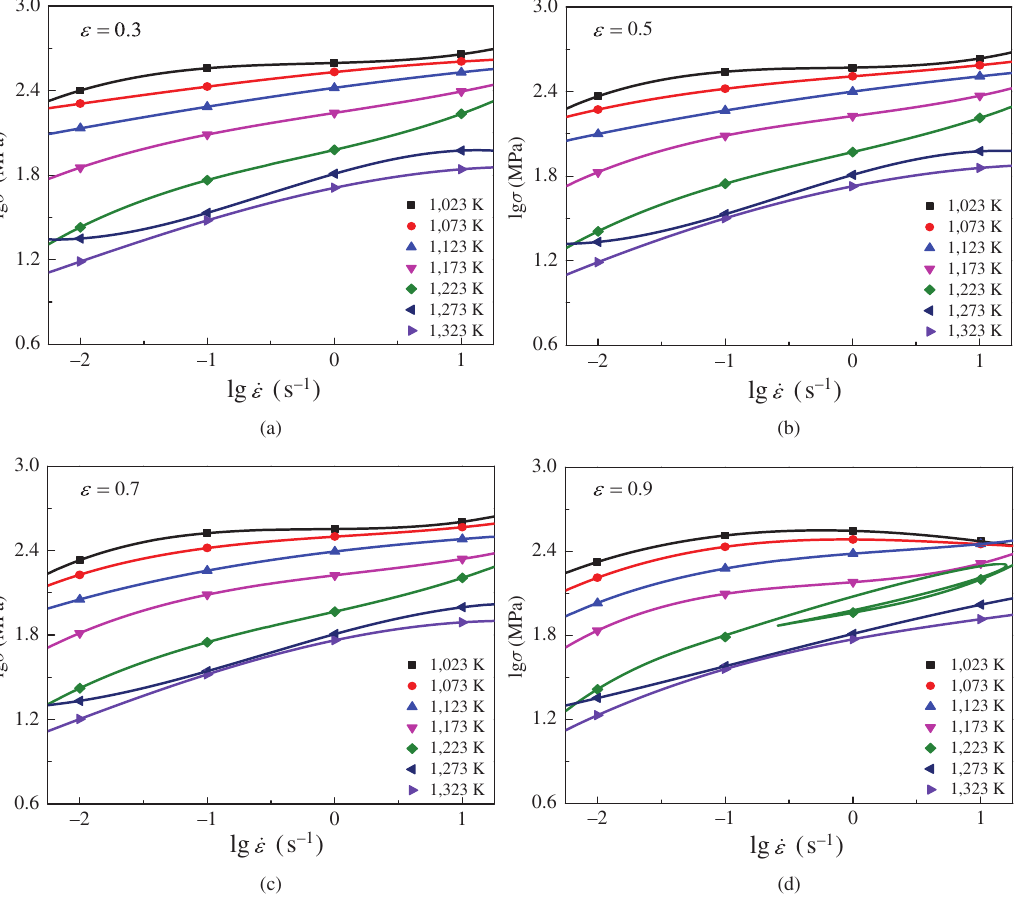
Figure 4 : The relationships between stress and strain rate in lg scale at different deforming temperatures and true strains: (a) " ¼ 0 : 3 , 1,023 – 1,323 K, (b) " ¼ 0 : 5 , 1,023 – 1,323 K, (c) " ¼ 0 : 7 , 1,023 – 1,323 K, (d) " ¼ 0 : 9 , 1,023 – 1,323